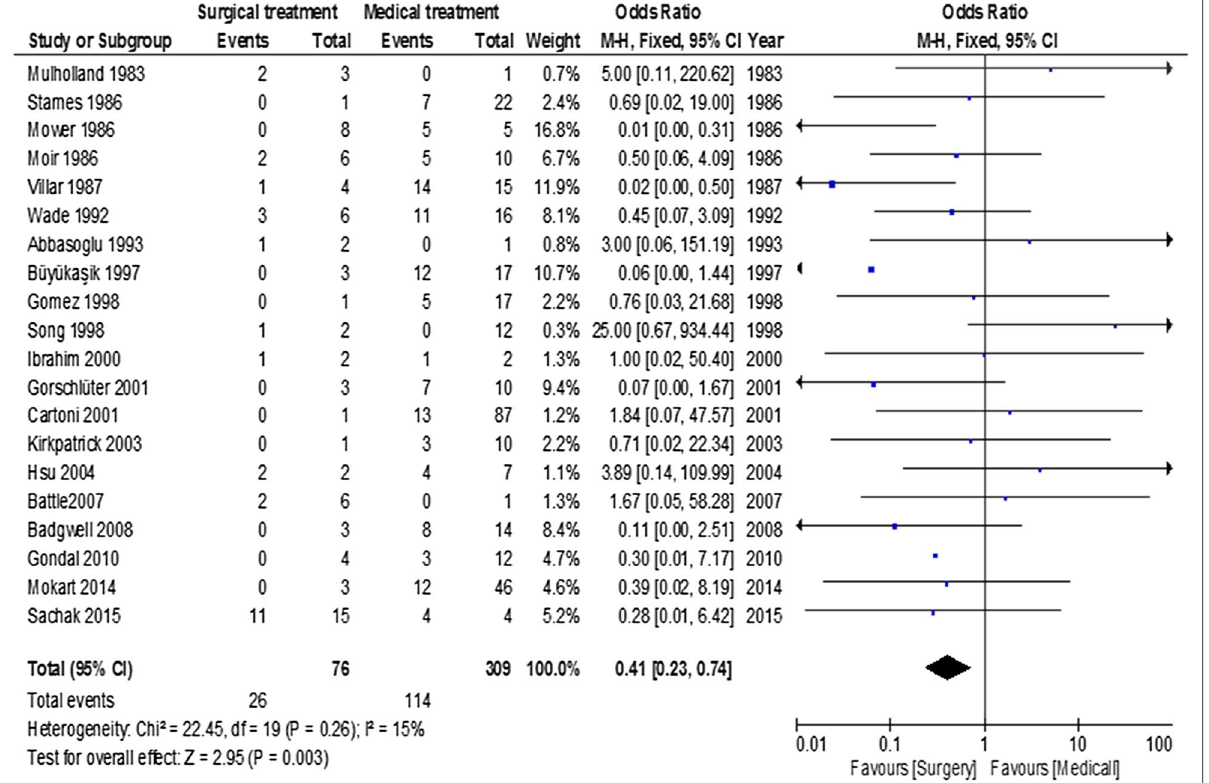
Fig. 3 Summary of odds ratio in included studies according to treatment arm (abdominal surgery versus medical conservative